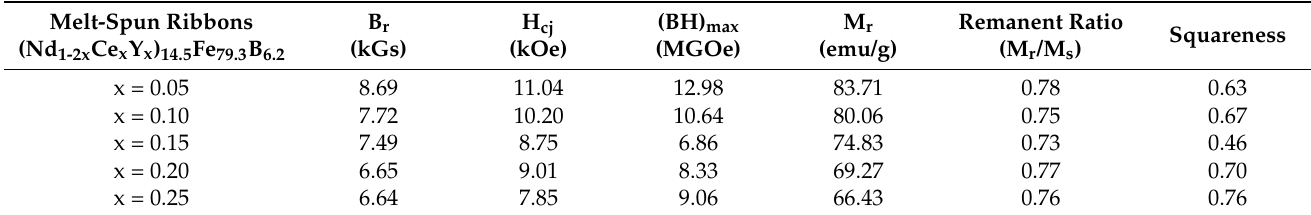
Table 1. Magnetic properties of (Nd 1-2x Ce x Y x ) 14.5 Fe 79.3 B 6.2 melt-spun